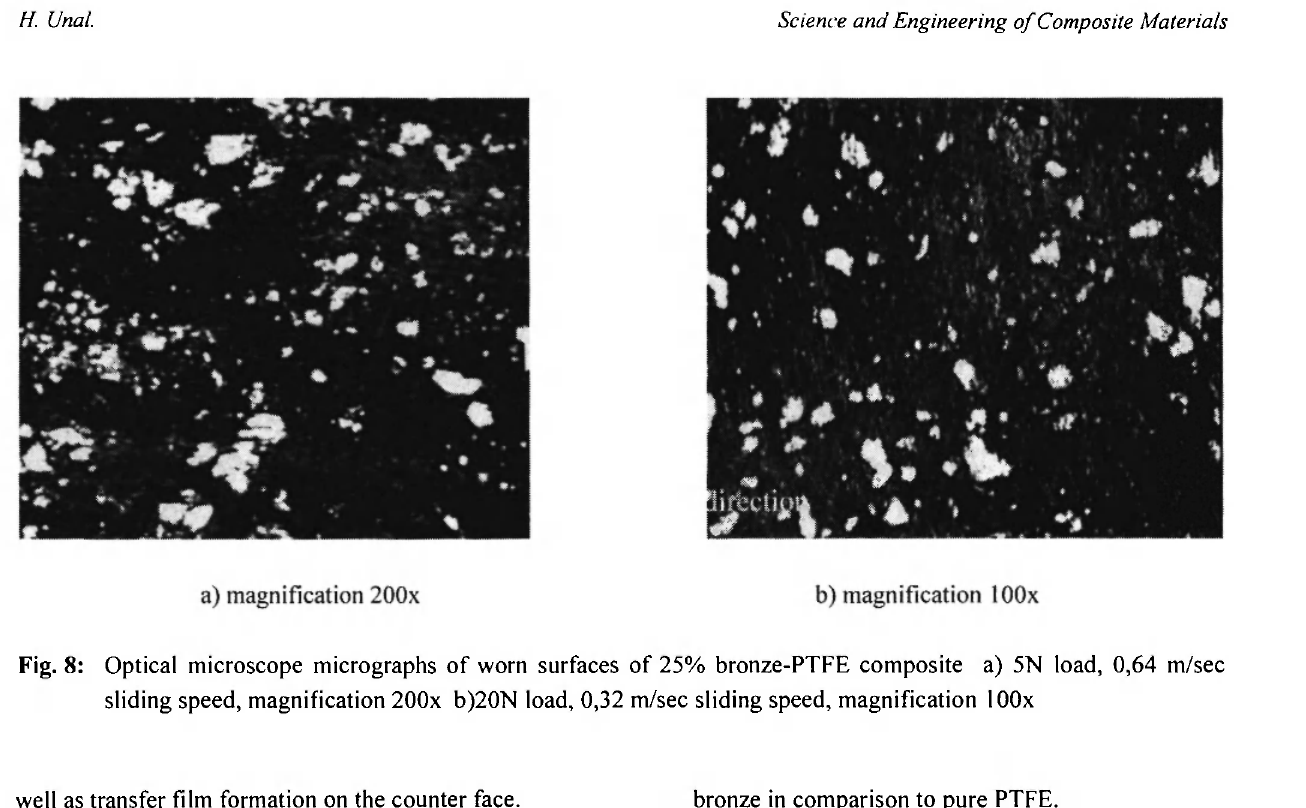
Fig. 8: Optical microscope micrographs of worn surfaces of 25% bronze-PTFE composite a) 5N load, 0,64 m/sec sliding speed, magnification 200x b)20N load, 0,32 m/sec sliding speed, magnification